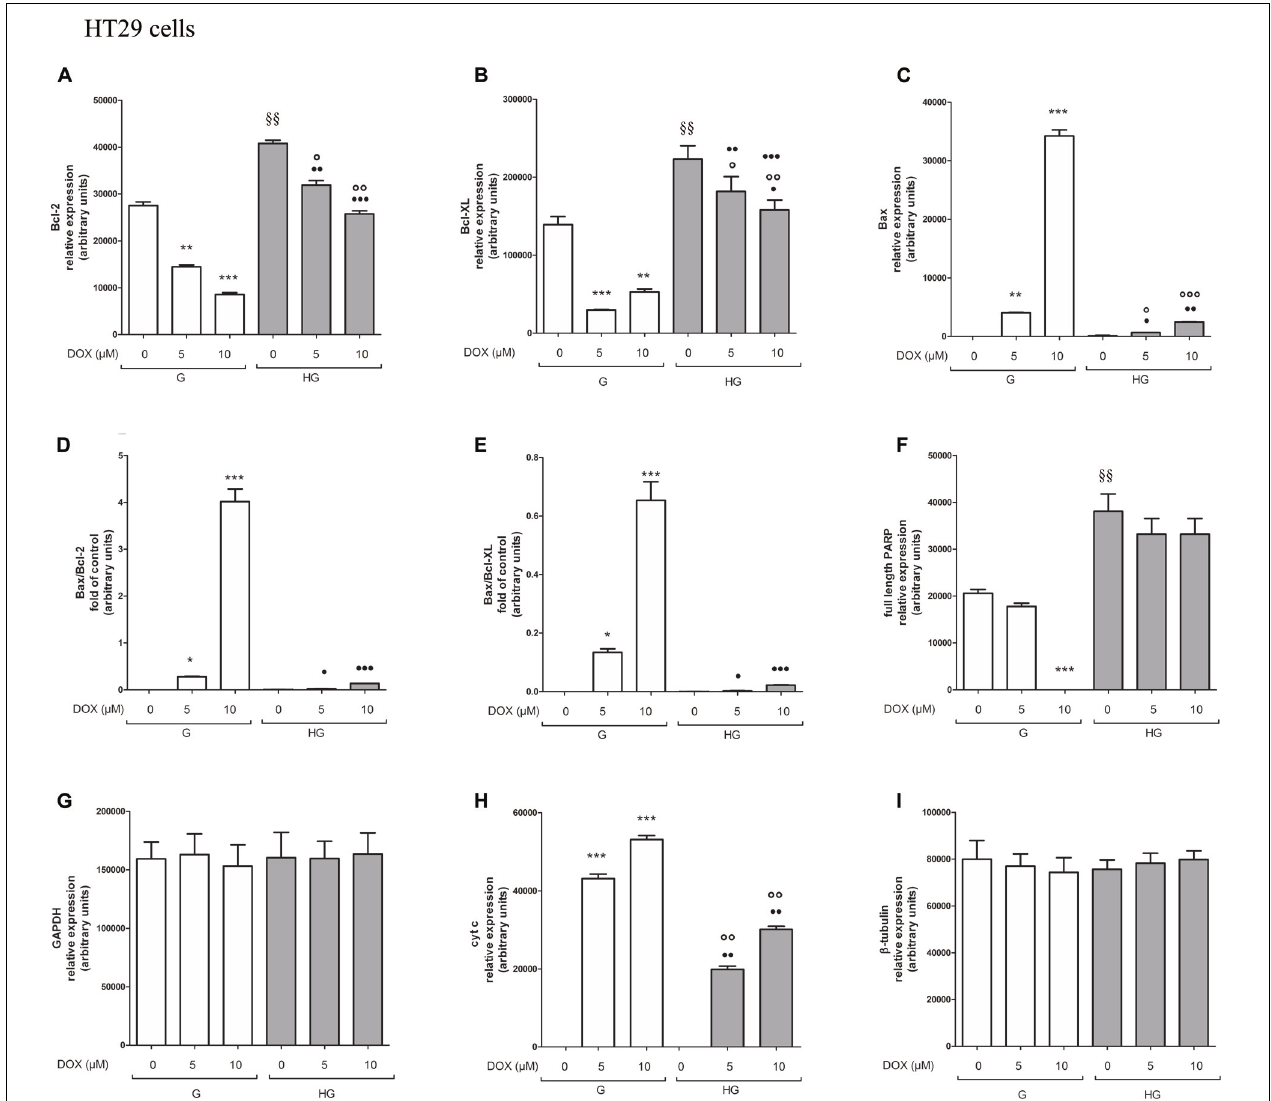
FIGURE 9 | Densitometry of Bcl-2, Bcl-XL, Bax, PARP, and cyt c protein expression in absence or presence of DOX in human colon cancer HT29 cells in G and HG conditions. The protein bands of three independent experiments have been quantified by densitometry and the values are expressed as arbitrary units. (A) For Bcl-2 measurements: ∗∗ p < 0.001 and ∗∗∗ p < 0.0001 5 and 10 µ M, respectively, DOX in HT29 cells cultured in G vs. 0 µ M DOX in HT29 cells cultured in G; §§ p < 0.001 0 µ M DOX in HT29 cells cultured in HG vs. 0 µ M DOX in HT29 cells cultured in G; ◦ p < 0.001 and ◦◦ p < 0.0001 5 and 10 µ M DOX in HT29 cells cultured in HG